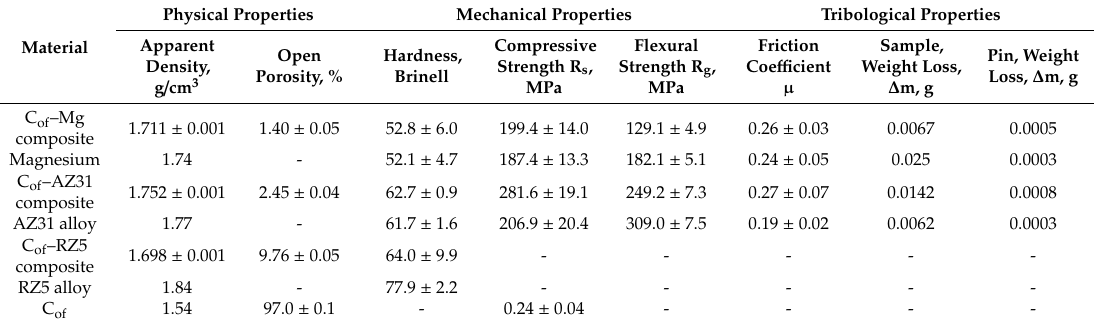
Table 2. Physical, mechanical and tribological properties of composites and component